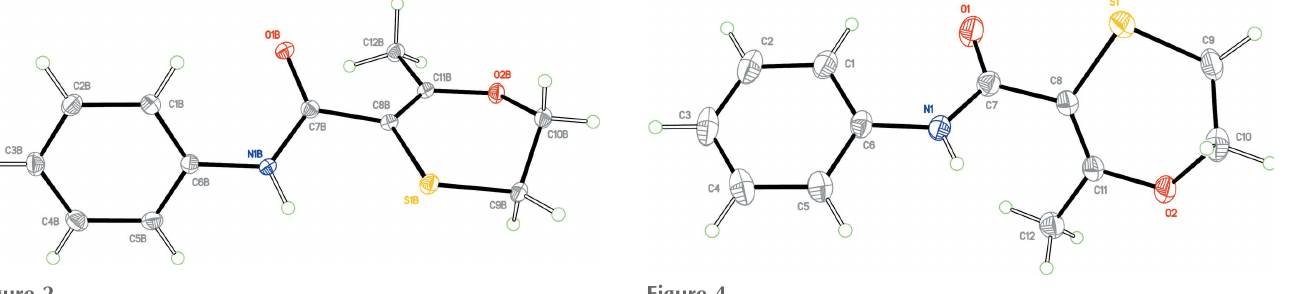
Figure 4 View of molecule 1 of the asymmetric unit of form 2 with the atom labelling scheme. Displacement ellipsoids are drawn at the 50% probability level.